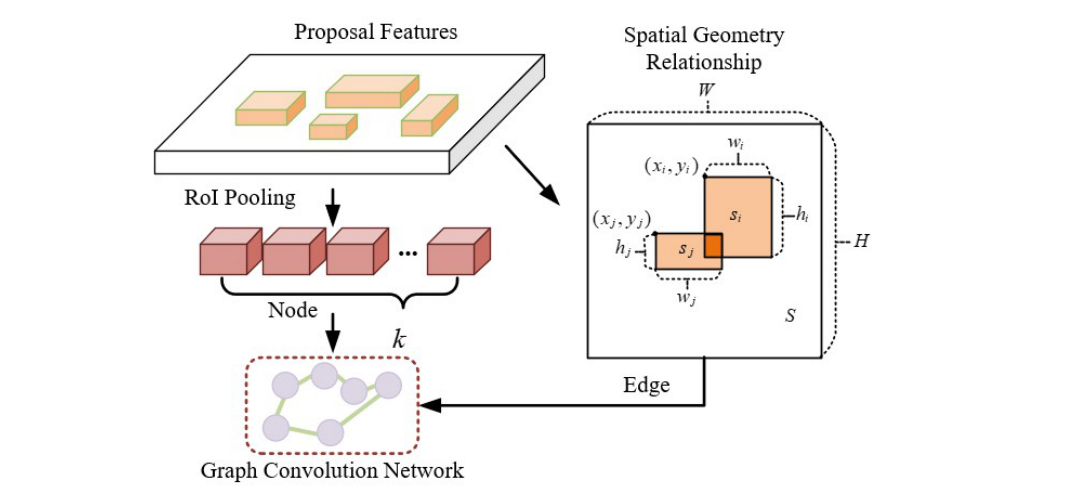
Figure 7. Architecture of the SGR